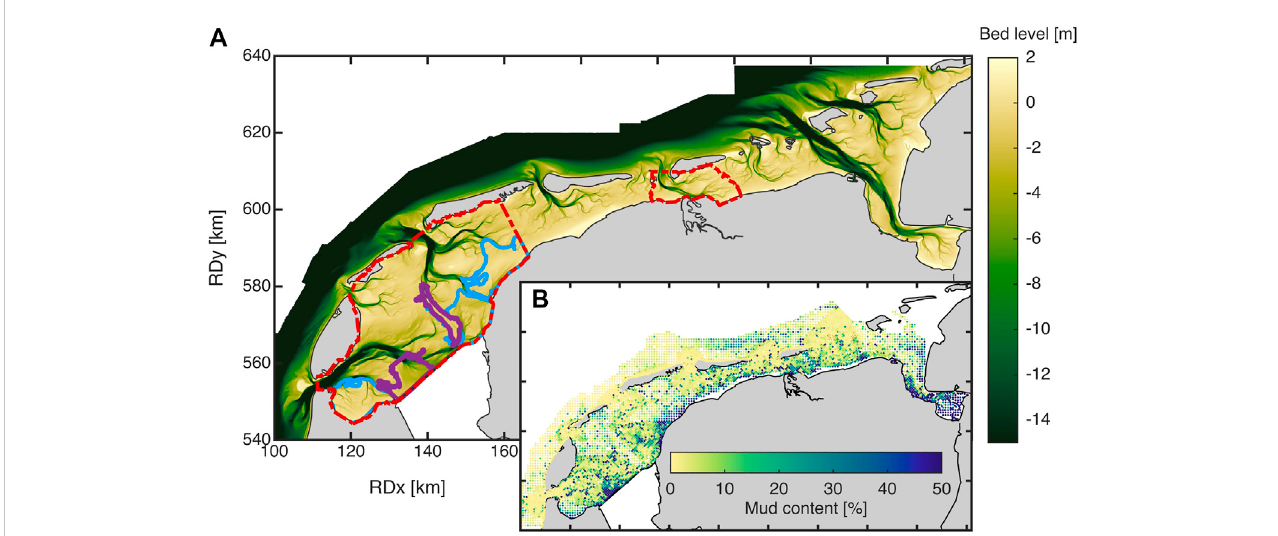
FIGURE 2 Wadden Sea bathymetry (A) , in meter below local reference level NAP) and mud content (B) , using the Dutch National Coordinate System (RD). The red dashed lines de fi ne the tidal basins of the Western Wadden Sea (left) and the tidal basin connecting to the Lauwers Sea (Zoutkamperlaag; right). The purple polygons within the Western Wadden Sea demarcate rapidly accreting channels; the blue polygons rapidly accreting shoal complexes (see Colina Alonso, 2021). The bathymetry is publicly available from the Ministry of Public Works; the mud content is computed from the Sedimentatlas (Rijkswaterstaat,